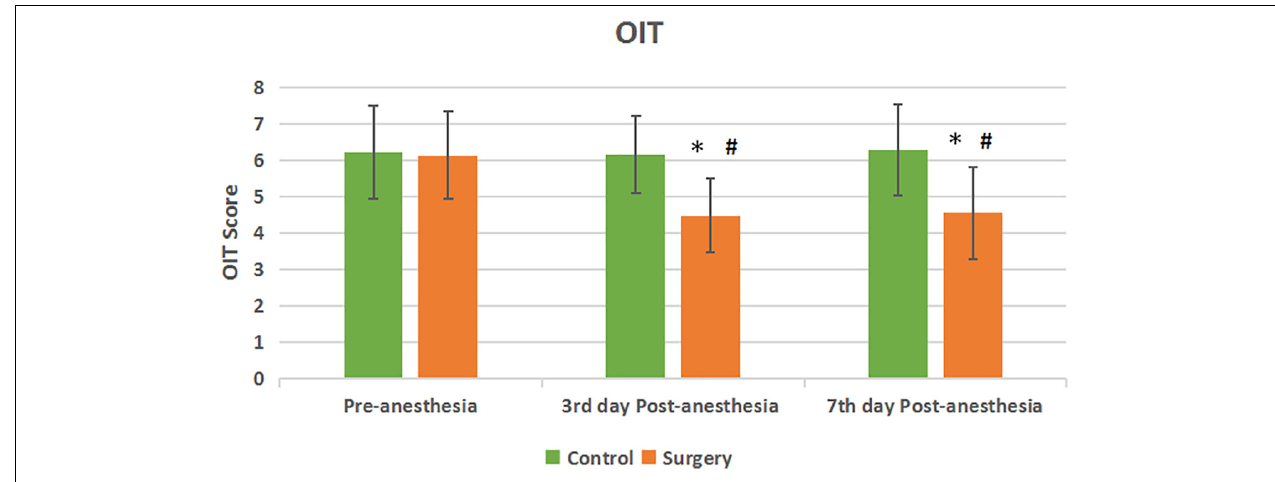
FIGURE 1 | Olfactory identification threshold between the two groups. Compared with Pre-anesthesia, the OIT score decreased at the 3rd and 7th day Post-anesthesia in the patients of surgical group. The difference between the two groups was statistically significant. Values are mean ± SEM. N = 30, * p < 0.05 vs. the control group; # p < 0.05 vs. pre-anesthesia.